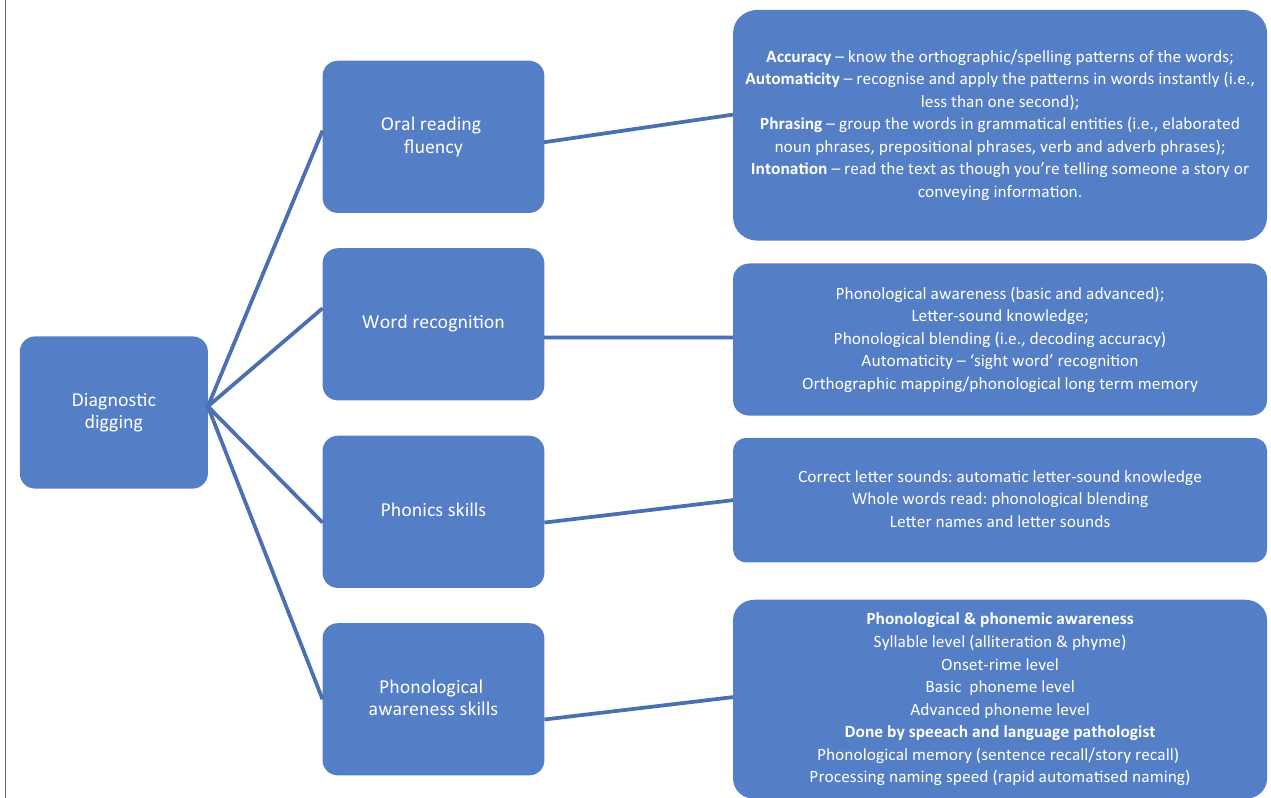
Diagnos(cid:24)c